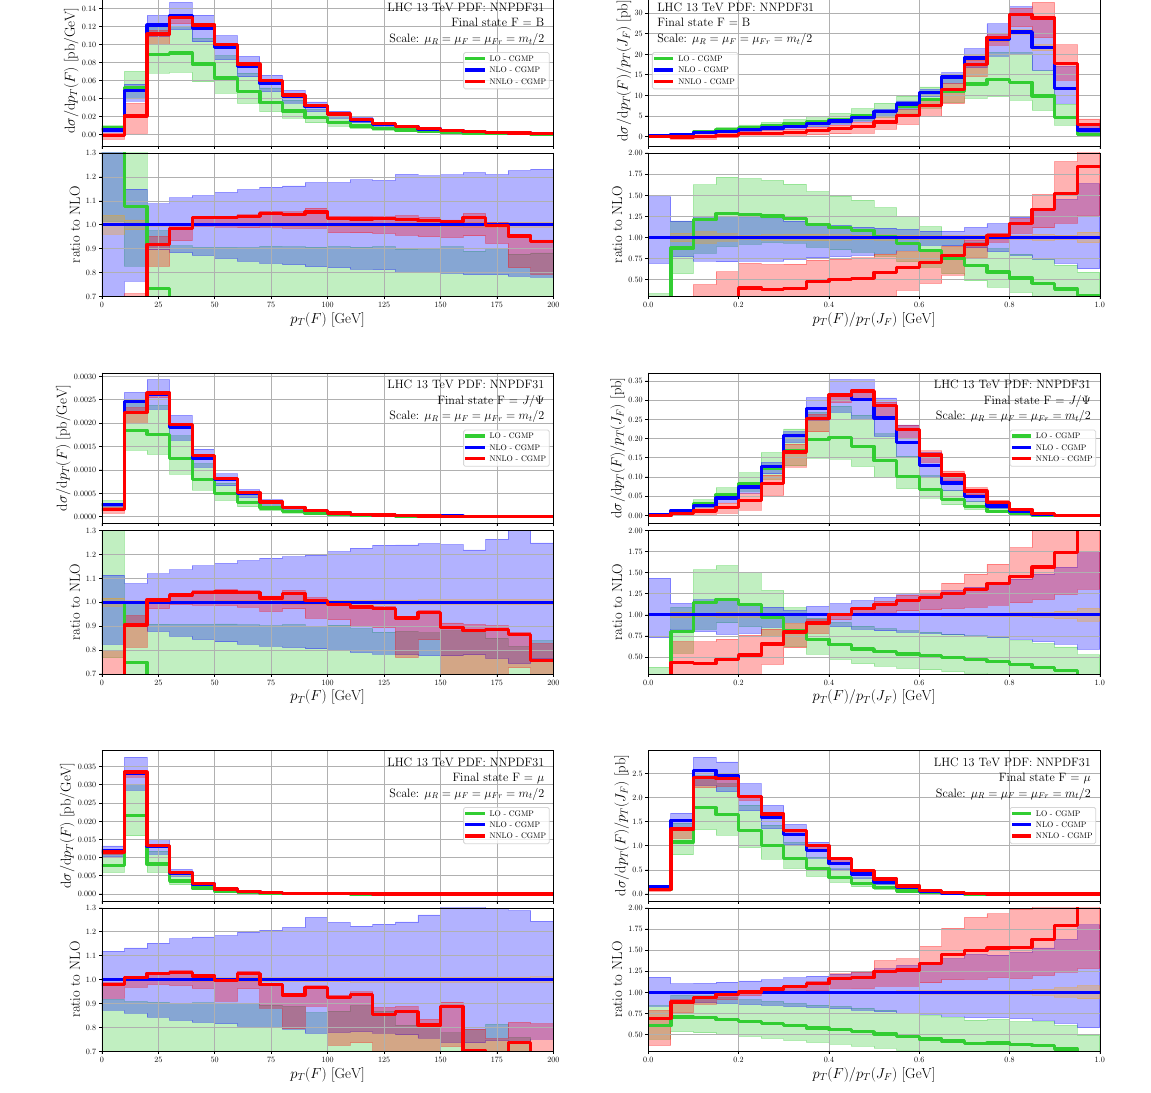
Figure 11 . As in figure 9 but for p T ( F ) (left column) and p T ( F ) /p T ( J F ) (right column).